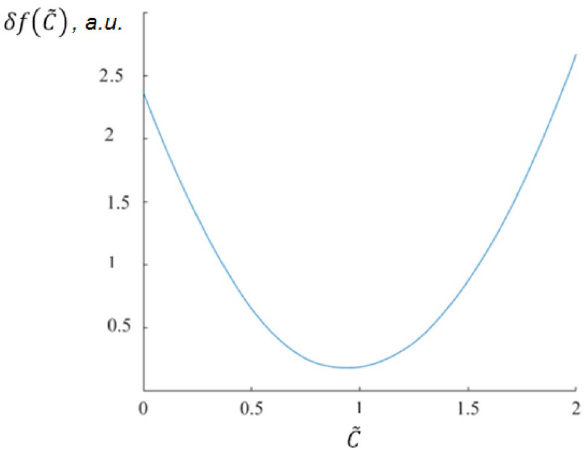
C . Here, the true concentration value C is equal (cid:31)